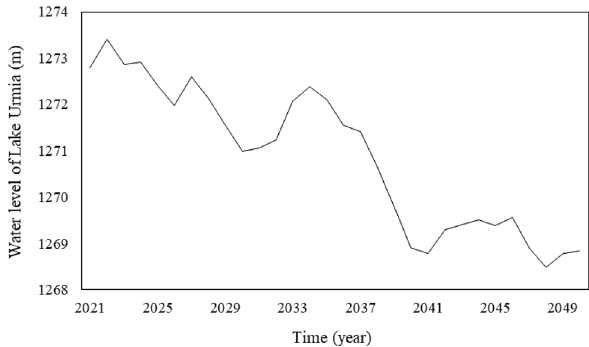
Figure 8. Predicted water levels of Lake Urmia in 2021–2050.